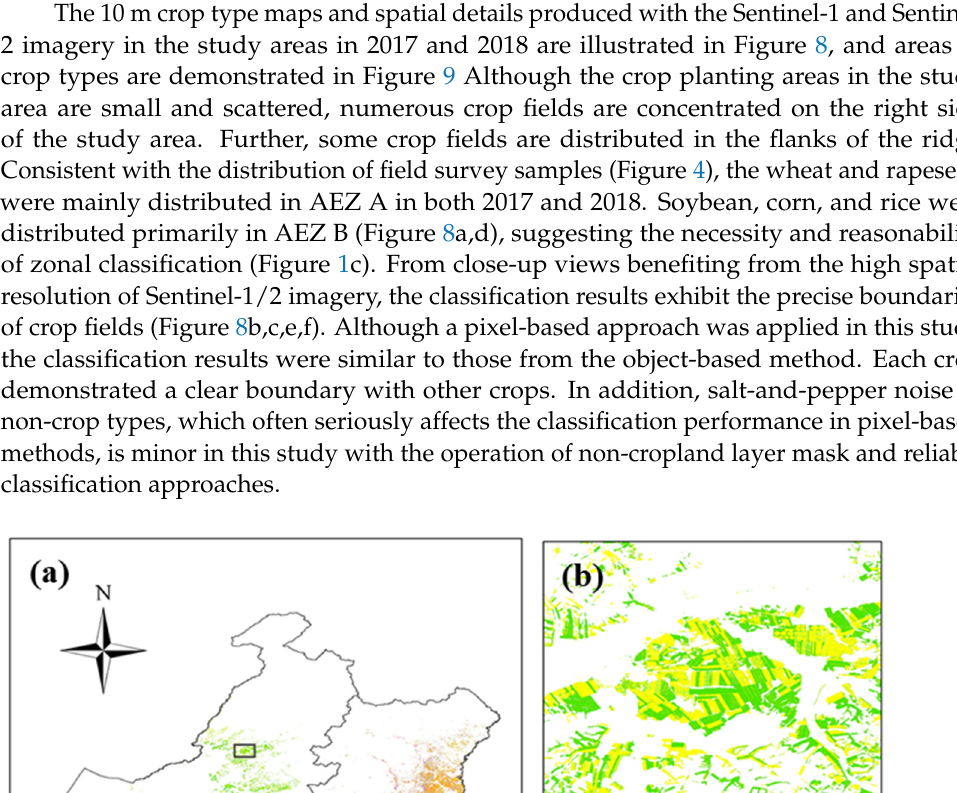
Figure 8. The crop type distributions of ( a ) 2017 and ( d ) 2018 over the study area; ( b , c ) are the close- up views of ( a ) for the AEZ A and B; ( e , f ) are the close-up views of ( d ) in the same regions of ( b , c ).